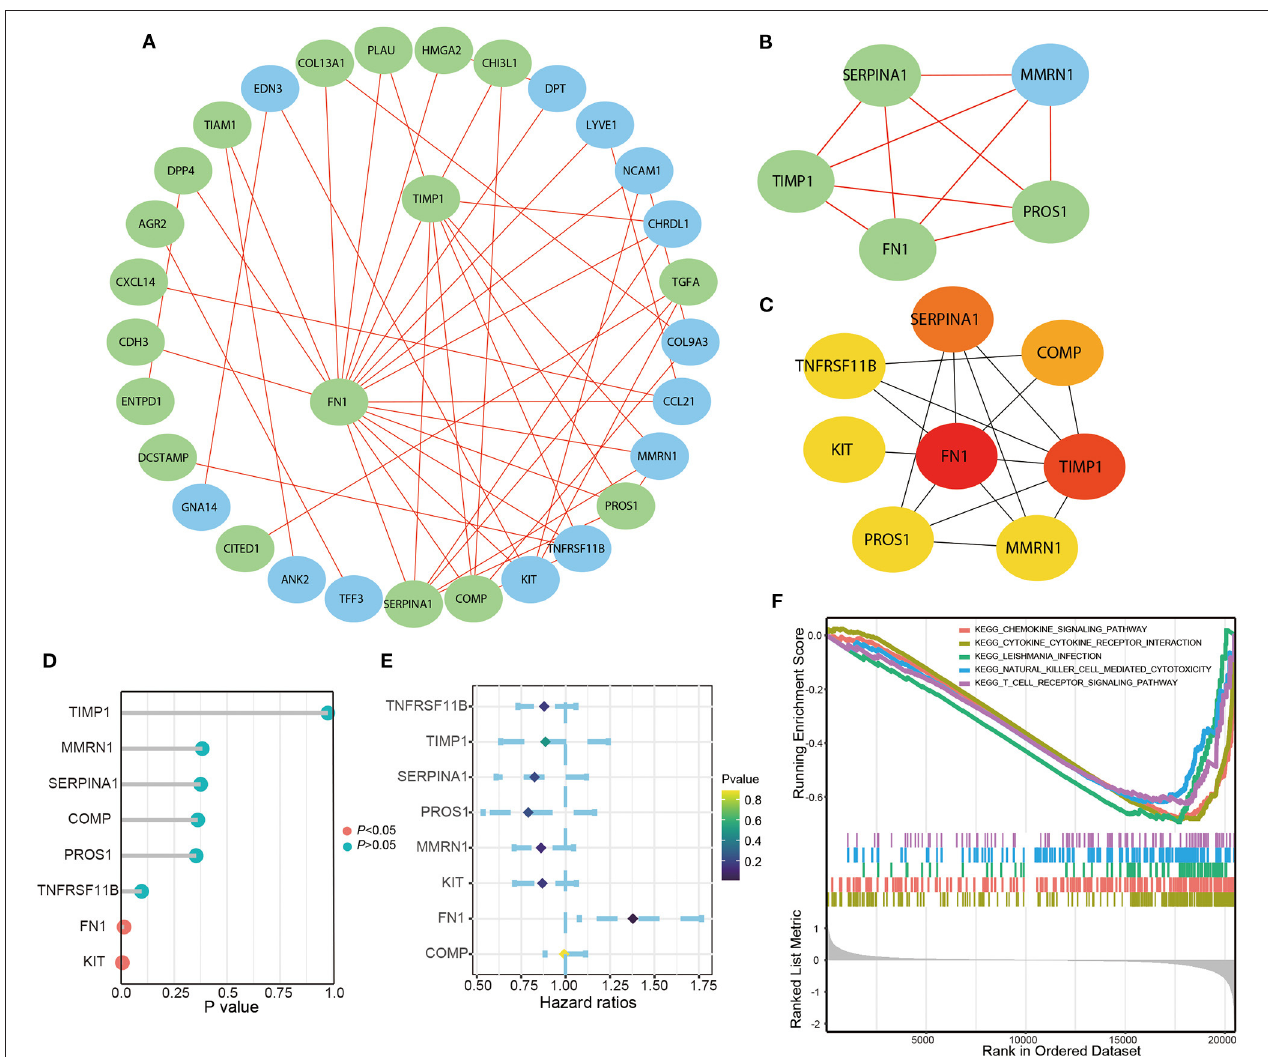
FIGURE 2 | The Screening and identification of key genes. (A) PPI network constructed with the DEGs in biological progress. (B) The most significant module obtained from PPI network. (C) The top eight hub genes. The logrank analysis of hub genes (D) and the multivariate cox logistic regression analysis (E) of hub genes based on the TCGA database. (F) The significant kegg pathways of FN1 in THCA obtained by GSEA.